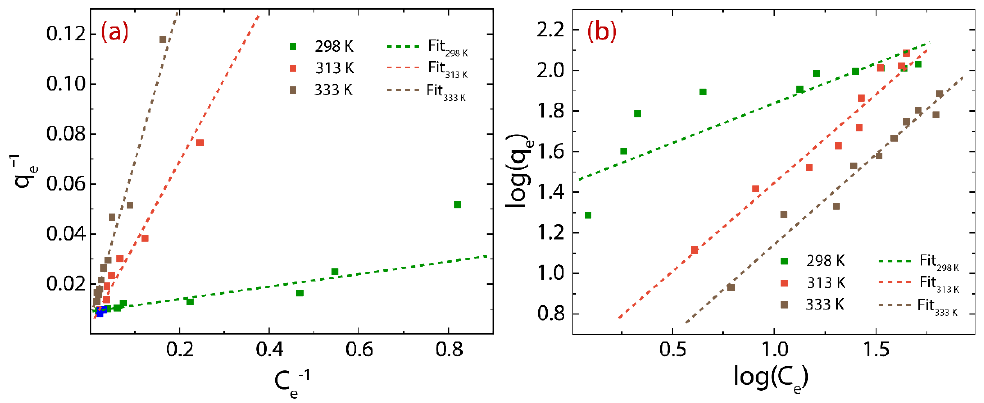
Figure 7. Adsorption isotherms: ( a ) Langmuir model and ( b ) Freundlich